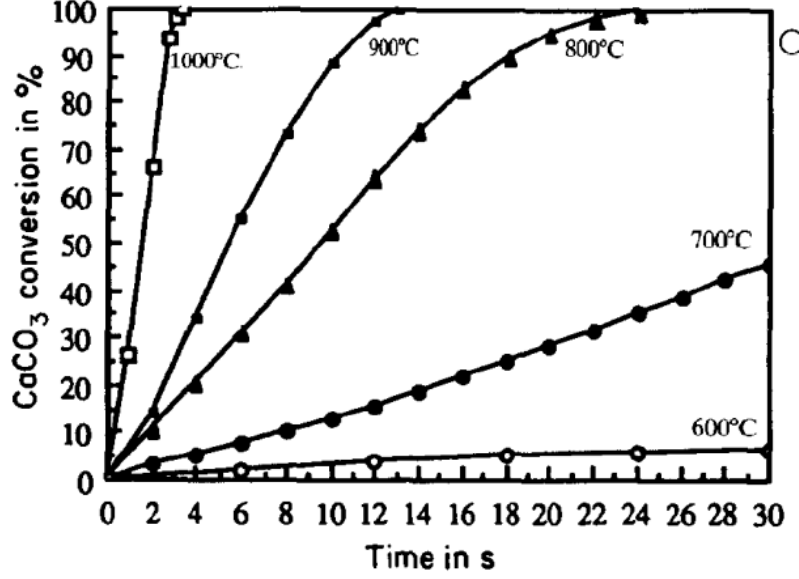
Figure 3. Effect of reaction time and temperature on the calcination efficiency at 1 mbar and 600-1000 °C [20].